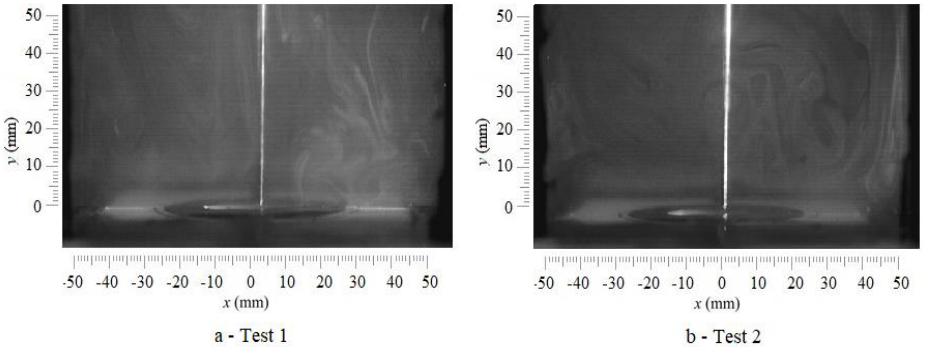
Figure 6. Comparative analysis of smoke flow visualizations at different percentage of amplitudes and fixed standoff distance 0 mm.